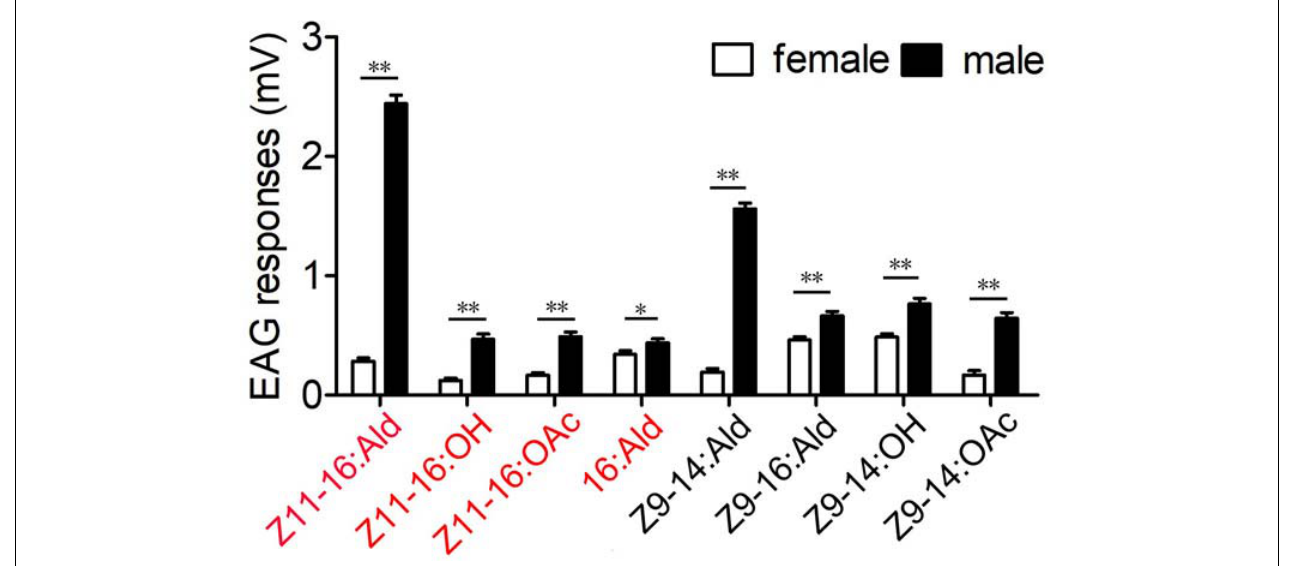
FIGURE 1 | Electroantennography (EAG) responses from antennae of male and female M. separata to four sex pheromone components (red) and four pheromone analogs (black). The EAG response values marked with asterisks represent significant differences between sexes ( ∗ , ∗∗ , respectively, indicate significant differences under 0.05 and 0.01 levels, determined by a Student’s t -test). Error bars indicate SEM ( n = 13).